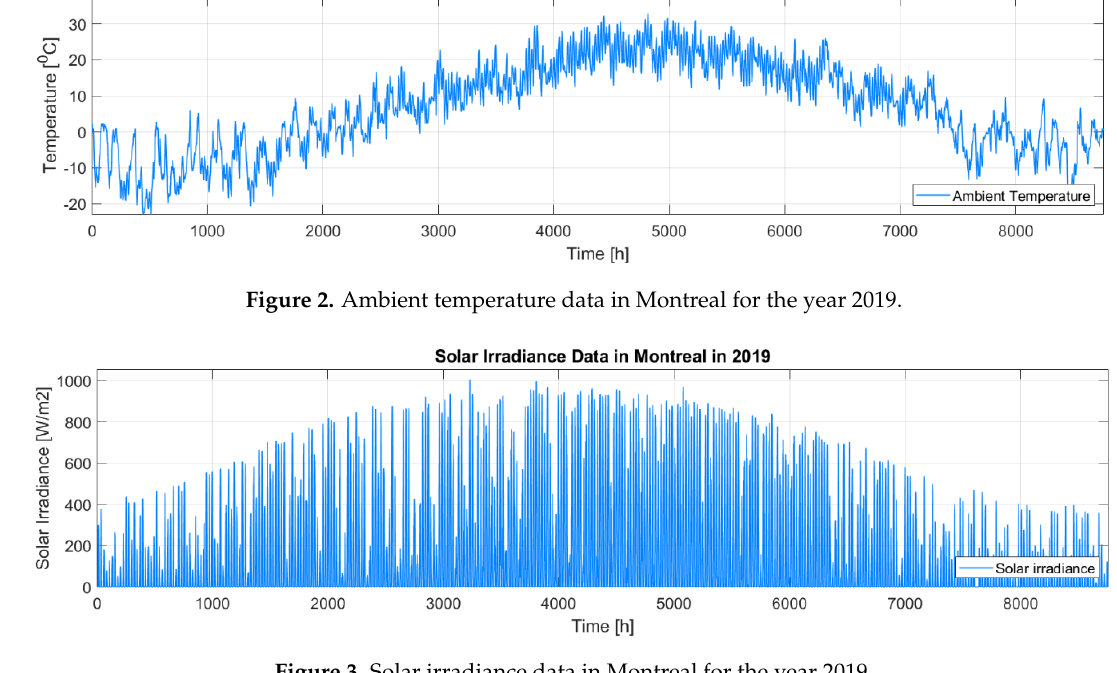
Figure 3. Solar irradiance data in Montreal for the year 2019.